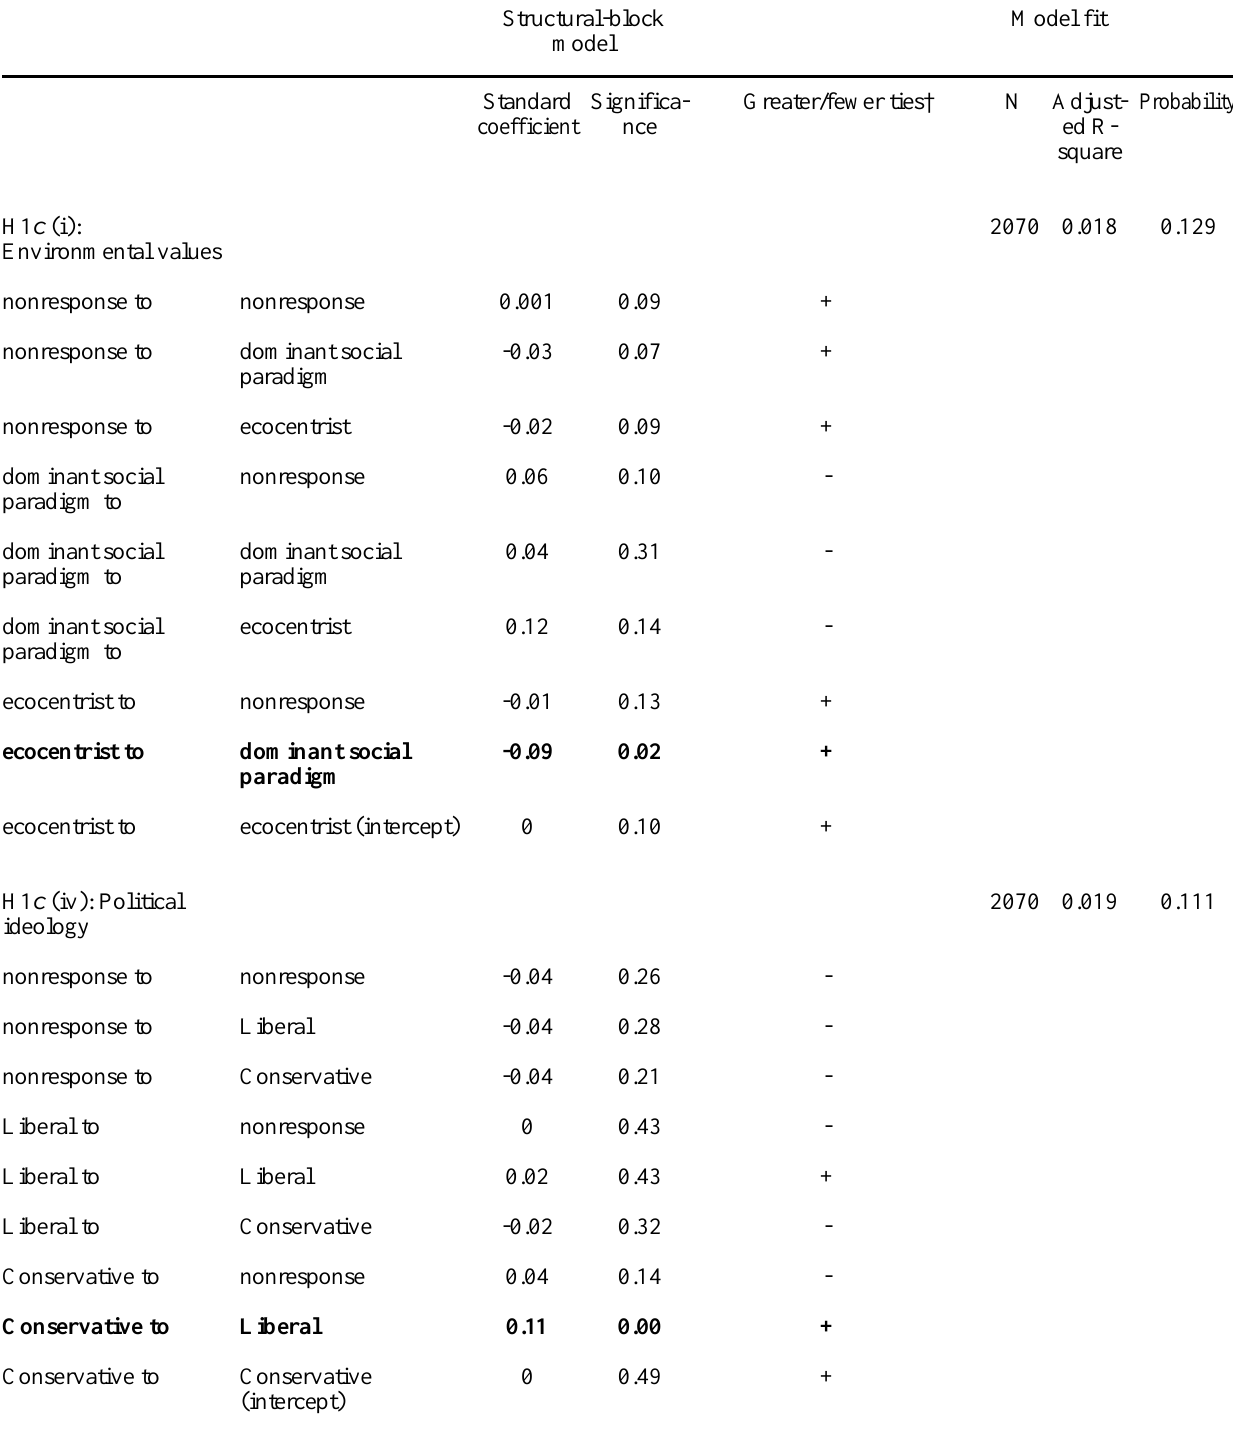
Table 3. Network autocorrelation with variables with significant pairwise